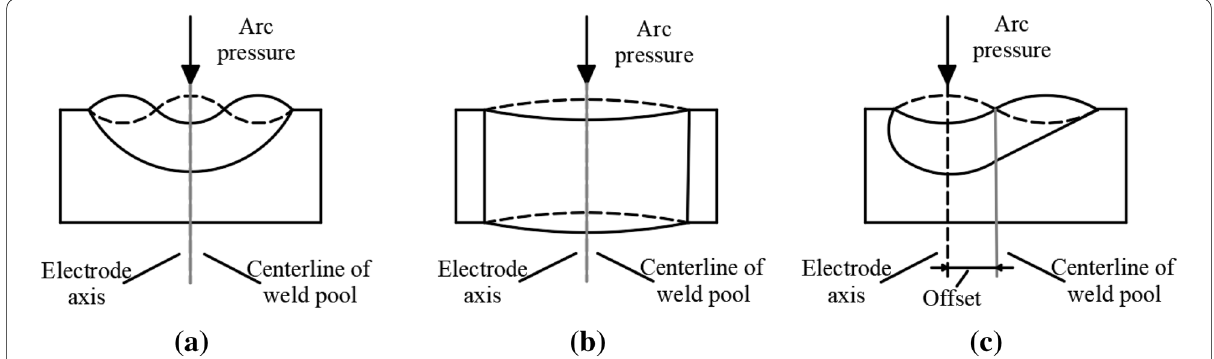
Figure 15 Different shapes of weld pool surfaces during